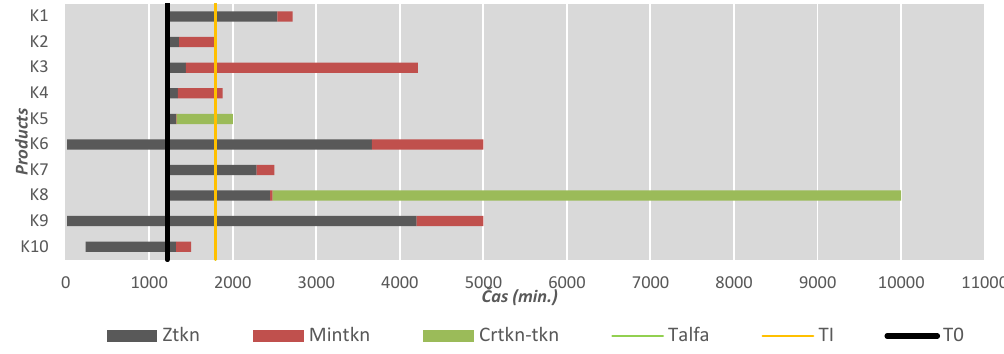
Figure 6. The chart of the third iteration for the product family.